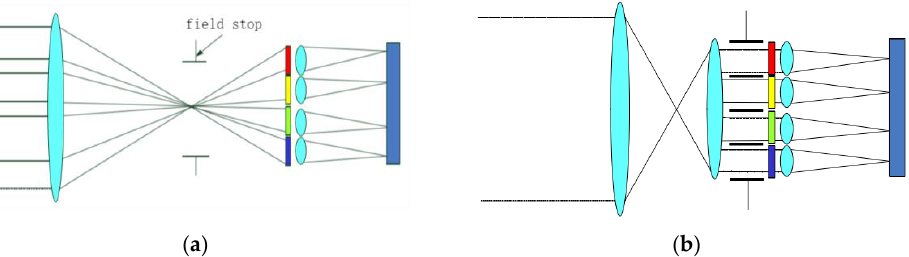
Figure 4. Schematic diagram of planar snapshot MSI system for front optical system. ( a ) Front-view far objective lens type. ( b ) Front telescopic system type.